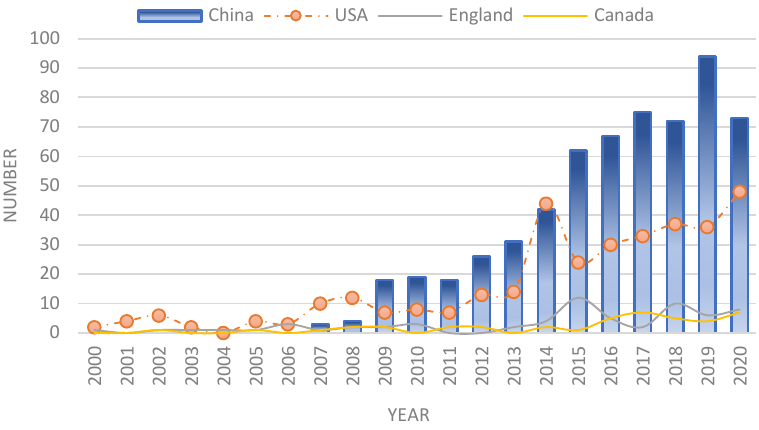
Figure 4. publication growth trend of 4 countries (China, USA, England, Canada) . Figure 4. Publication growth trend of 4 countries (China, USA, England,